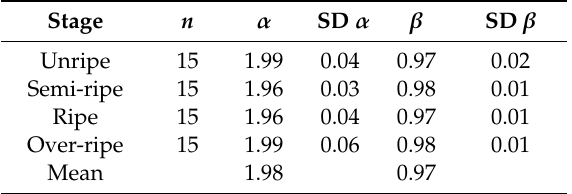
Table 2. α and β experimental values ( n -number of